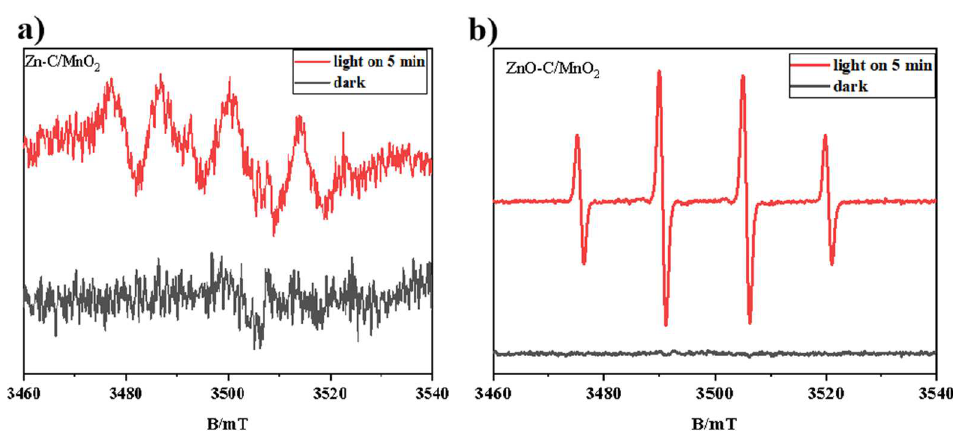
Figure 10. EPR spectra of ZnO‐C/MnO 2 under dark and simulated solar light: DMPO • O 2− ( a ) in